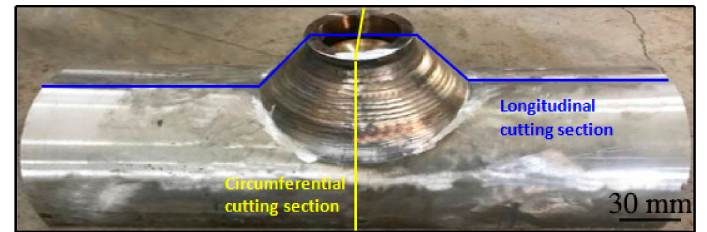
Figure 4. Section cutting